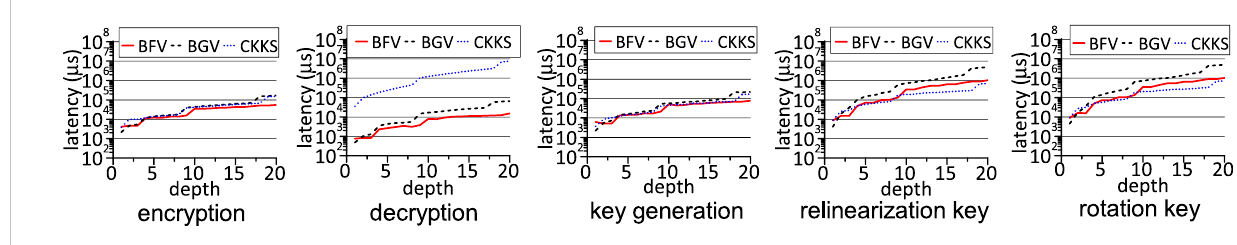
FIGURE 6 The latency comparison of client setup operations on a CPU for FHE.